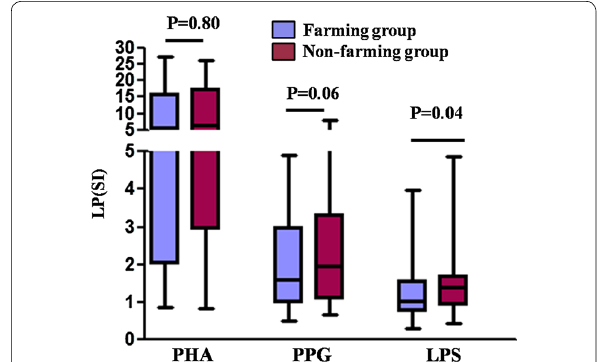
Fig. 1 Lymphocyte proliferation was decreased by LPS stimulation in the farming group. Lymphocyte proliferation of CBMCs were assessed in the farming (n 40) and non-farming (n 80) groups = = after PHA, PPG, and LPS challenge. Proliferation was assessed by counts per minute (cpm) and then quantified by stimulation index (SI stimulated LP (cpm)/unstimulated LP (cpm)), which was = calculated as the ratio of mean cpm of stimulated over unstimulated replicates. The values are represented as median (25%/75% IQR). Mann–Whitney Rank Sum Test was used to compare the two groups. Statistical significance is indicated by P values <